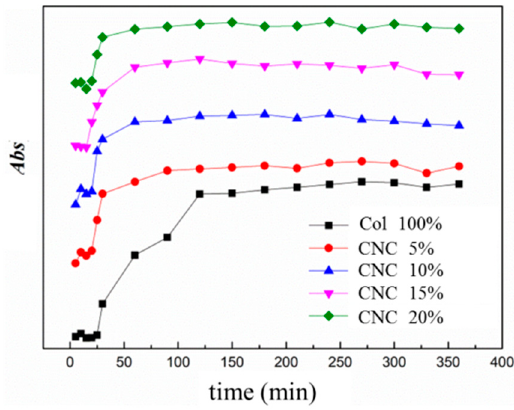
Figure 1. UV-vis characterization of CNC/Col assembly kinetics in PBS solution.